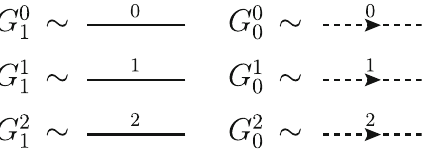
Fig. 5 Diagram technique element for the four-vertex